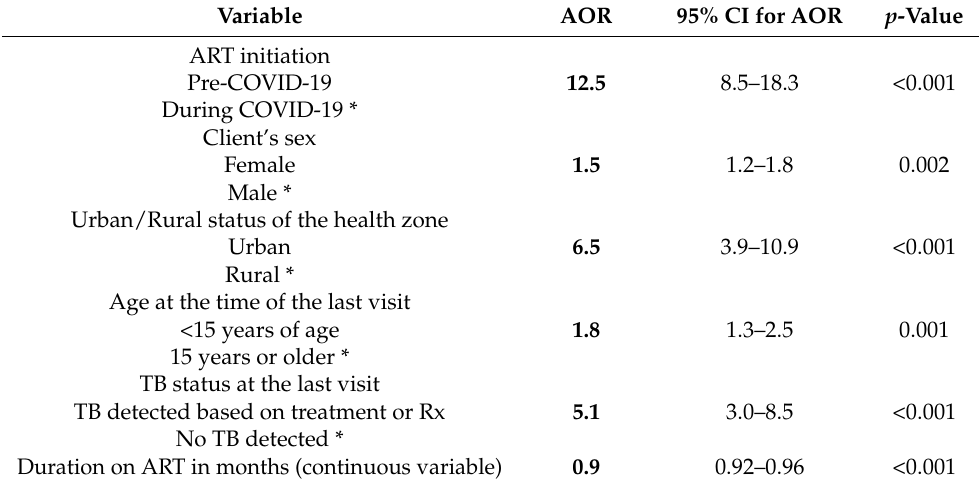
Table 2. Firth’s logistic regression of interruption in treatment in patients in HIV/AIDS clinics of Haut-Katanga and Kinshasa provinces, Democratic Republic of Congo, January 2014–May 2019. Variable